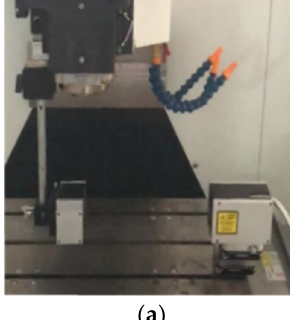
Figure 6. Thermal error compensation process.